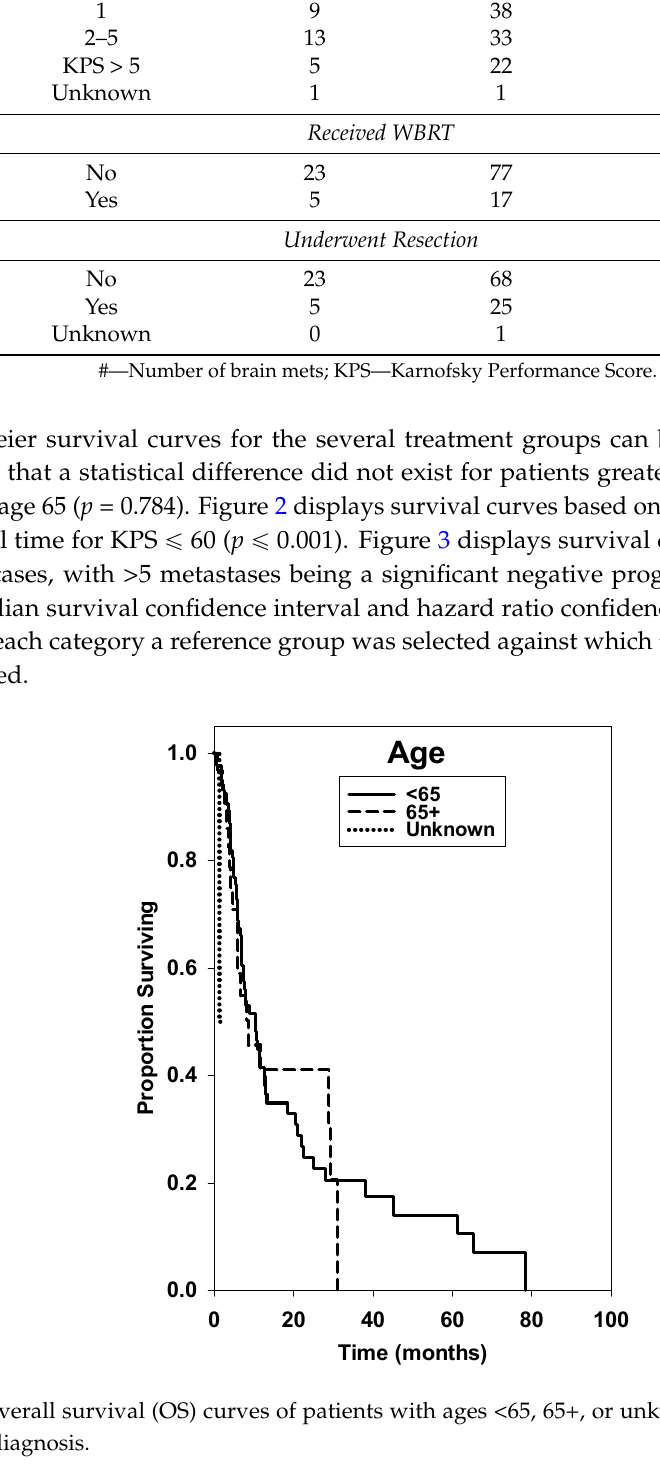
Figure 2. Overall survival curves of patients with Karnofsky Performance Score (KPS) of 90–100, 70– 80, ≤ 60, or unknown at time of initial Gamma Knife radiosurgery (GKRS) treatment.